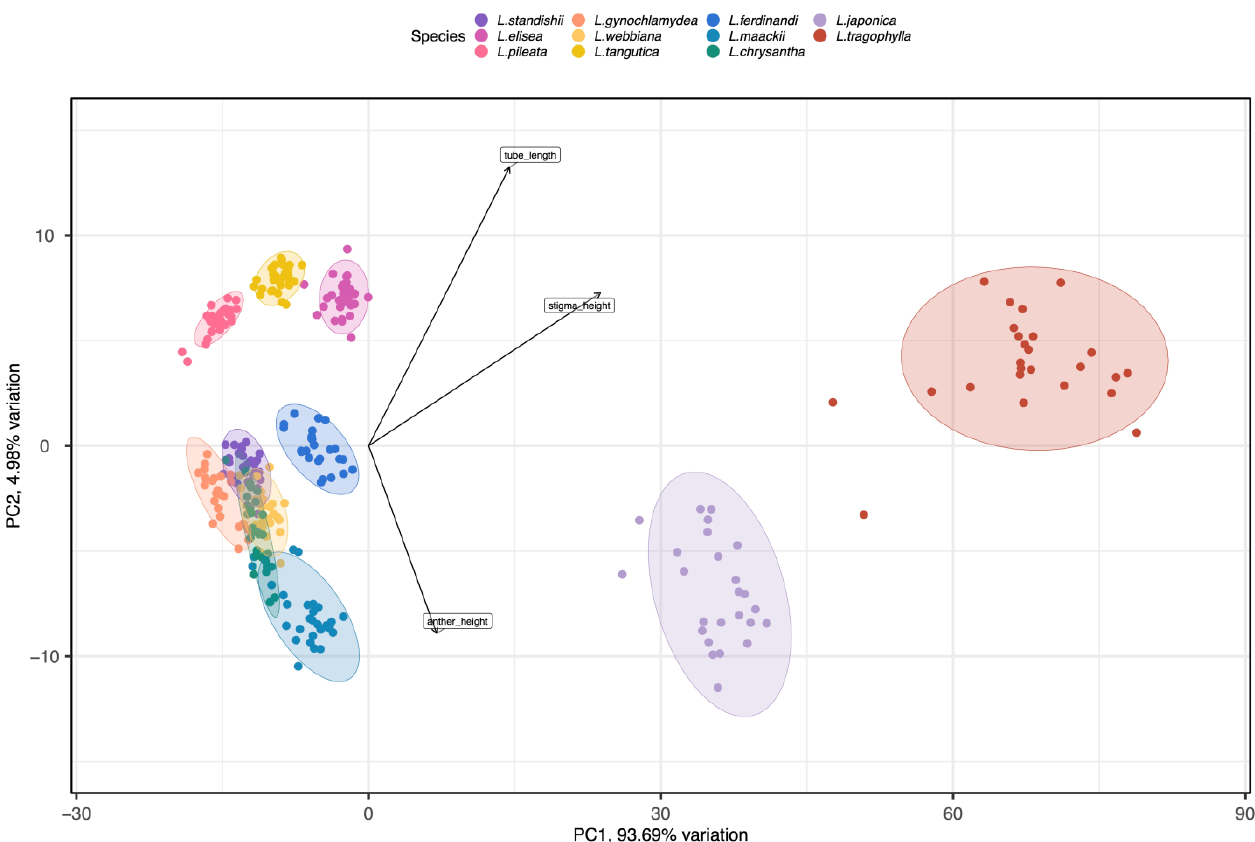
Figure 1. PCA analysis of eight floral traits (corolla tube length, throat diameter, anther height, stigma height, upper corolla lip length/width, and lower corolla lip length/width) among the 11 Lonicera species. Most variance among plant species in phenotypic traits was explained by the first (PC1) and second (PC2) principal components (93.69% and 4.99%, respectively). Tube length, stigma height, and anther height had the highest scores regarding PC1 (see arrows). Different colors represent the different study species. Ellipses include 96.13% of samples from each species.